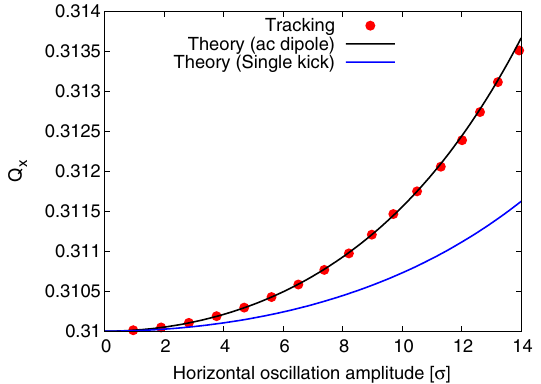
FIG. 3. Direct term of amplitude detuning for the combined effect of nonlinear field components up to B 10 . The red dots are the result of the tracking, the blue line is the model prediction for free oscillation, and the black line represents the model with all coefficients rescaled by n . Tracking data are consistent with the model for free oscillation corrected by a factor n